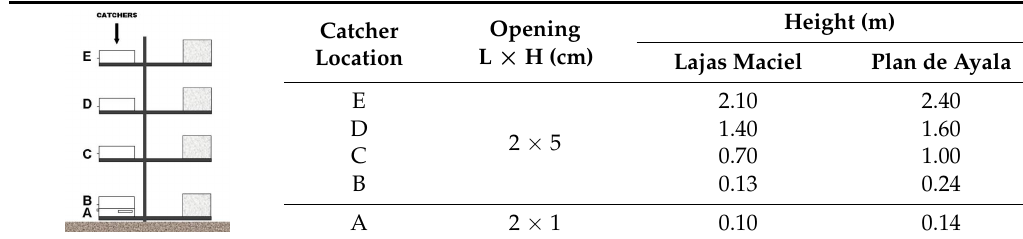
Table 1. Area of openings and height of each Big Spring Number Eight (BSNE) sediment catcher. The BSNE tower arrangement is diagrammed to the left.